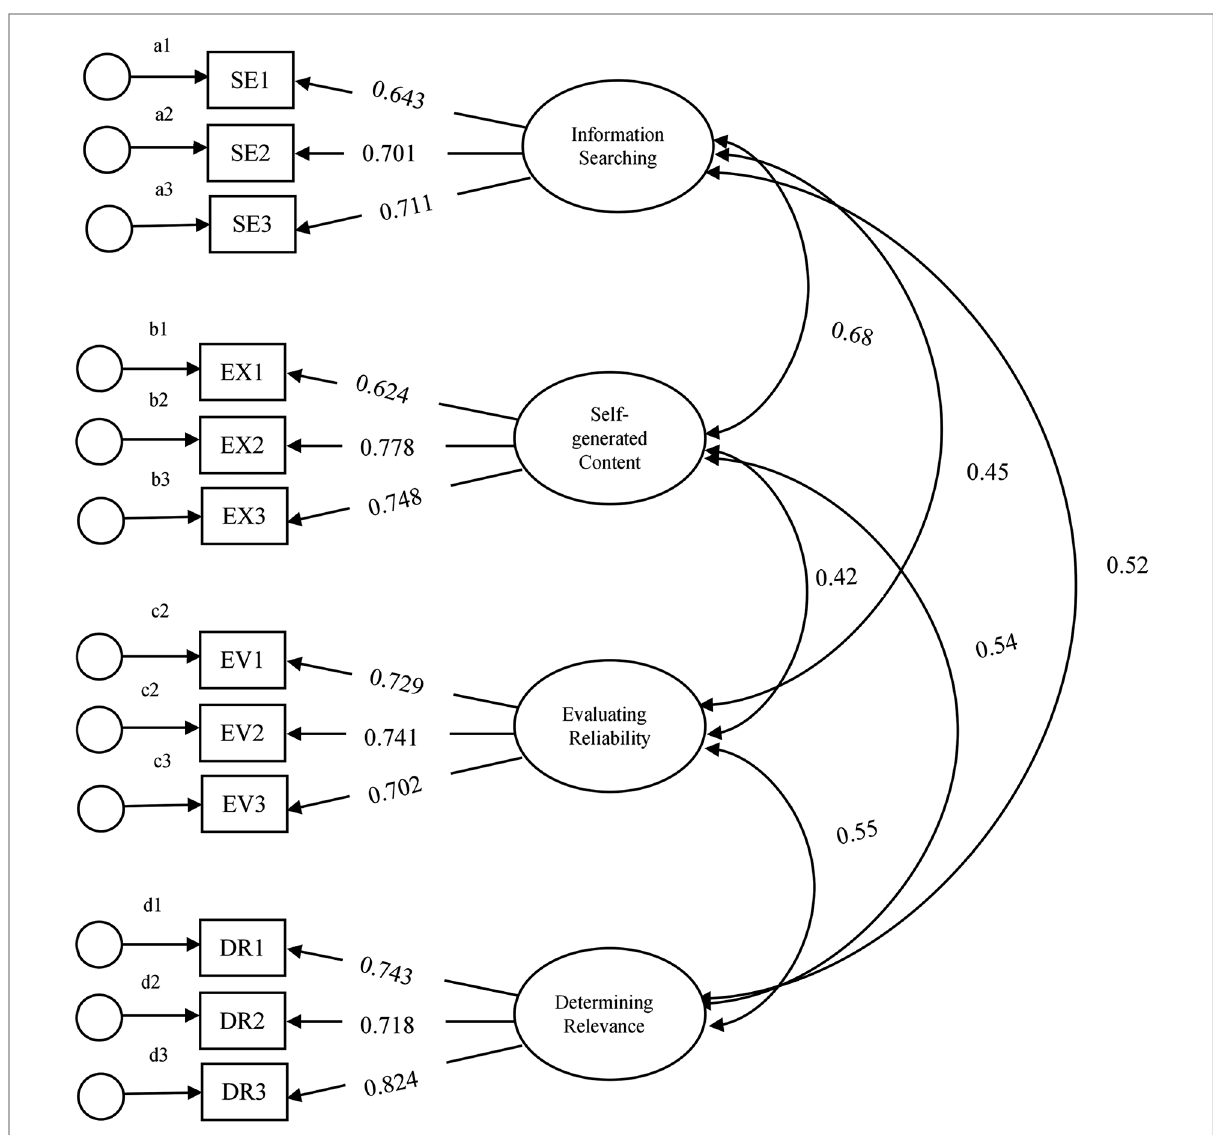
FIGURE 1 First order CFA model with 4-factor structure and 12 items.